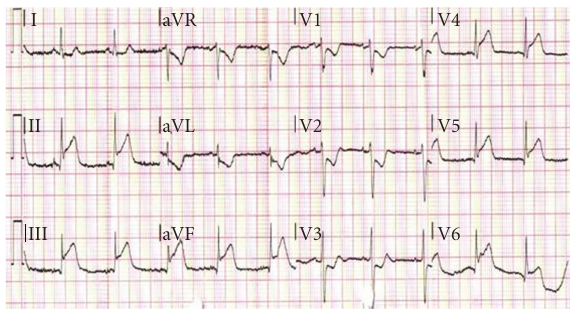
Figure 1: Presenting electrocardiogram demonstrating presumed ST-elevation myocardial